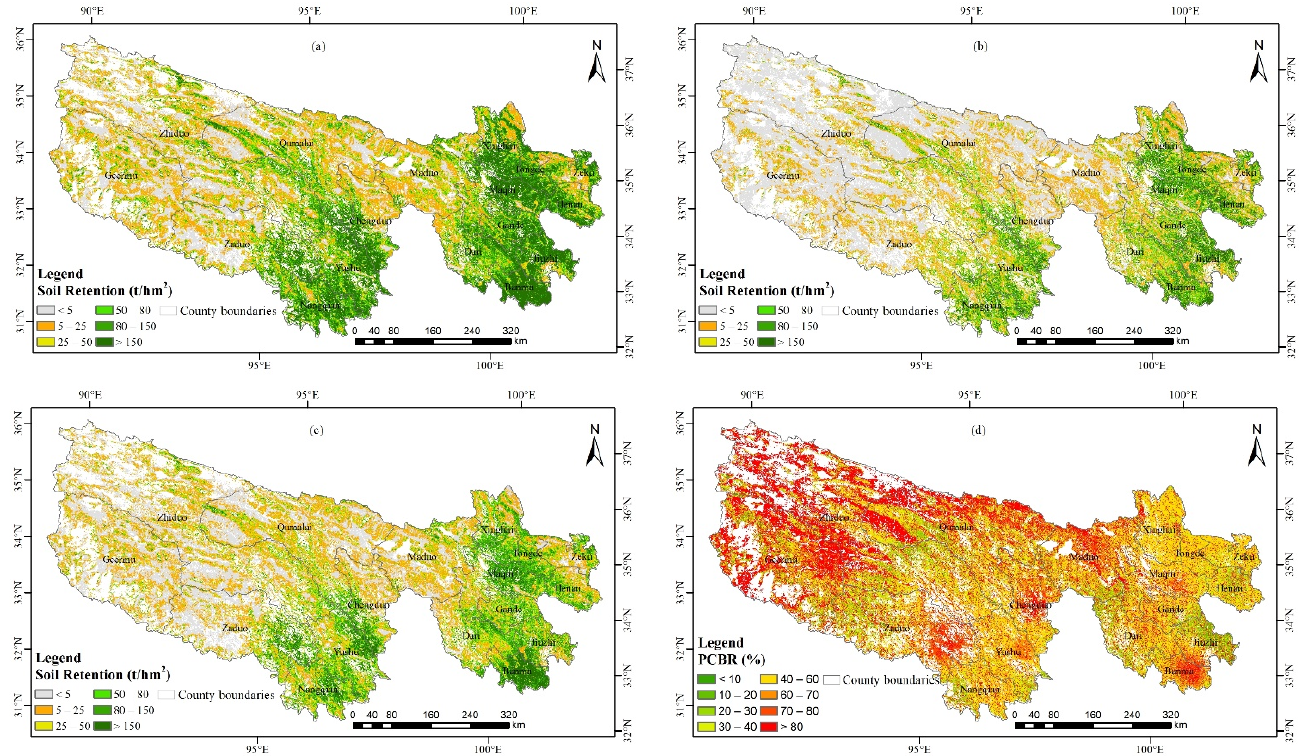
Figure 7. Spatial distribution of average annual soil retention ( a ), change trend ( b ), significant ( c ) and percentage ( d ) of forest and grass ecosystems in the TRHR from 2000 to 2019. Table 4. Statistical table of climax background, restoration degree, restoration potential, and PCBR of SR in TRHR’s